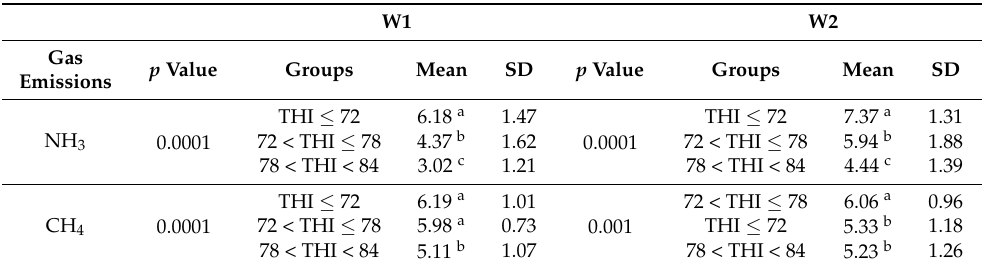
Table 3. Results of statistical analyses for gas emissions at different groups of THI during W1 and W2. W1 W2 Gas p Value Groups Mean Emissions